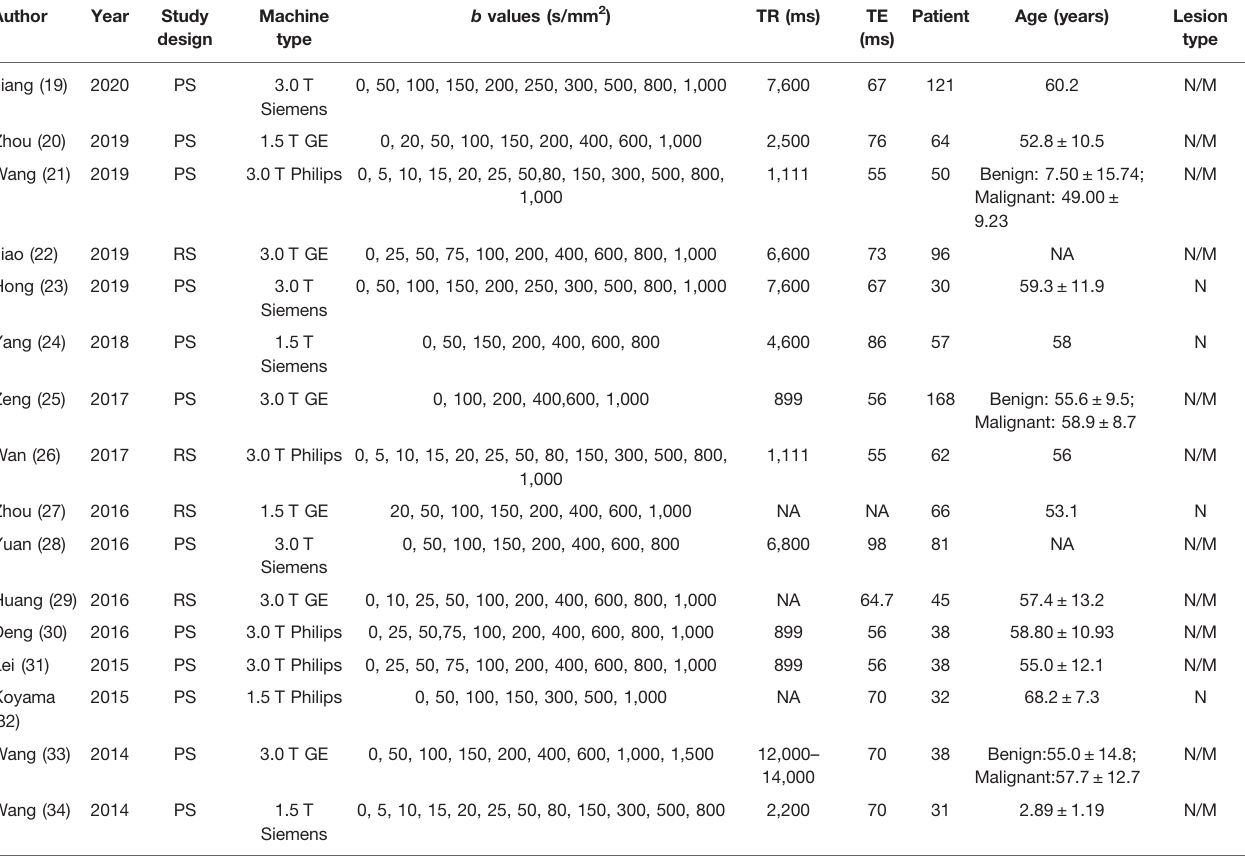
TABLE 1 | Basic information for each